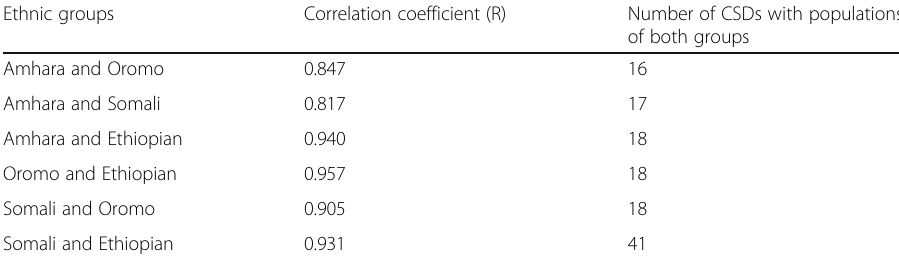
Table 1 Co-residence of selected ethnic groups in census divisions and census subdivisions, 2006 census Ethnic groups Correlation coefficient (R) Number of CSDs with populations